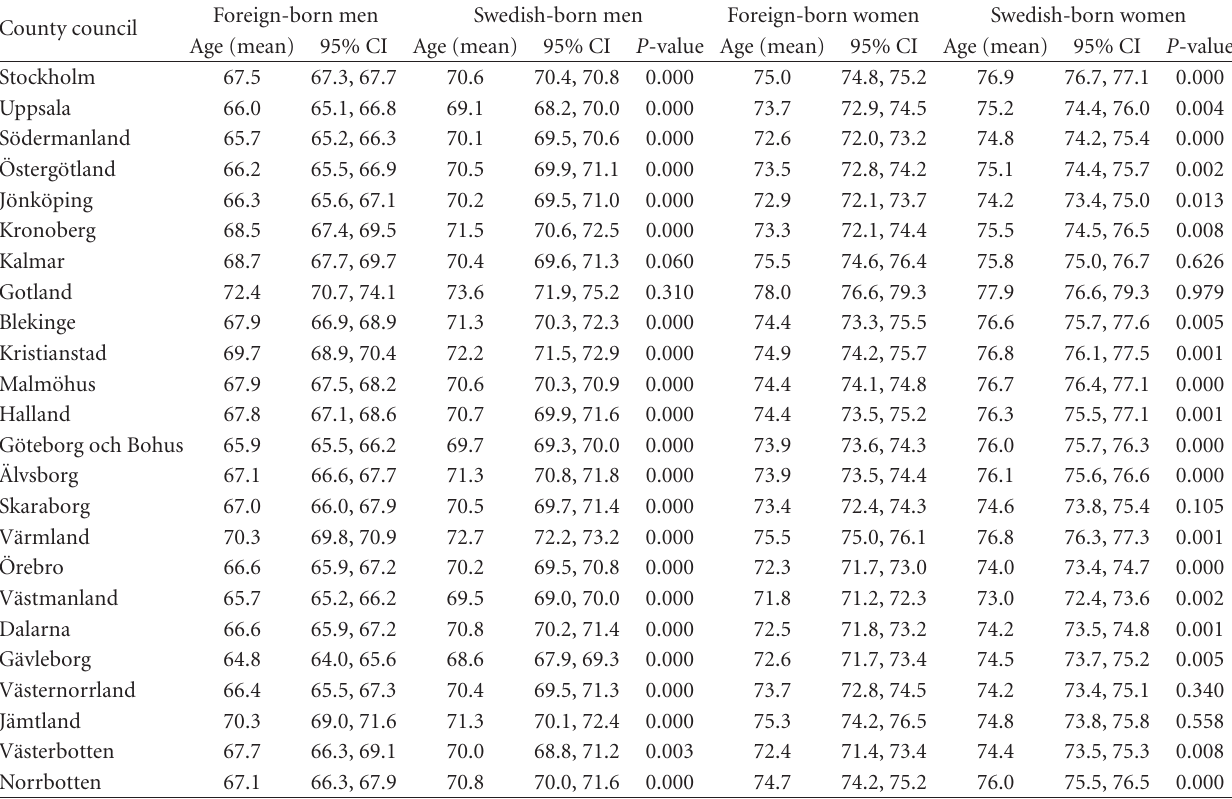
Table 5: Deceased in relation to age at time of death and latest county council of